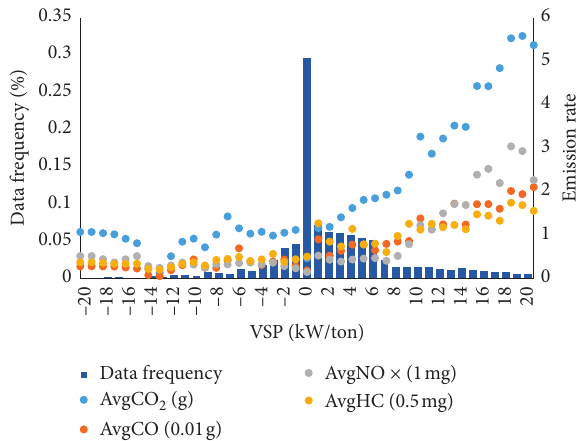
Figure 8: Mean emission rates in each VSP